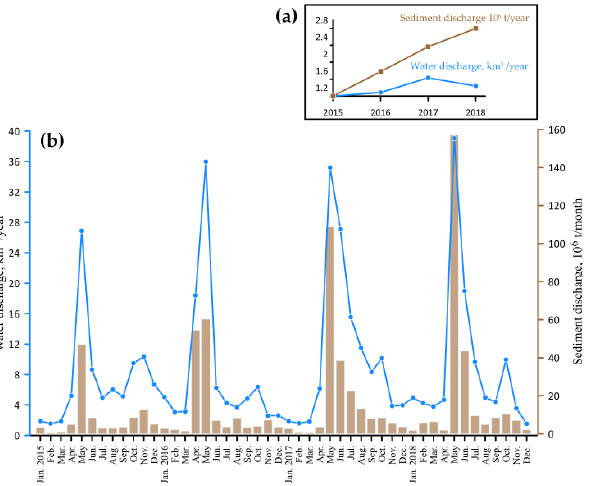
Figure 2. Water and suspended sediment discharges of the Severnaya Dvina in the period from 2015 to 2019 ( a ); inter-annual variation of water and sediment discharges in the period of investi- gations ( b